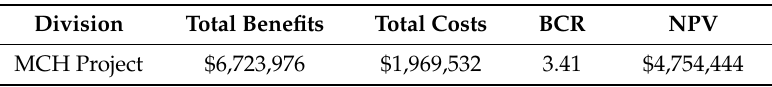
Table 4. The results of the cost-benefit analysis (CBA) for the MCH